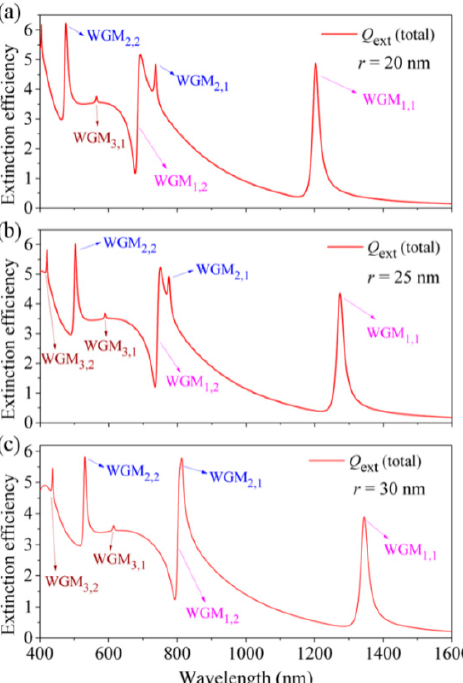
Figure 7. ( a – c ) The calculated total extinction efficiency spectra of the spherical HMM cavity for different r from 20 nm ( a ) and 25 nm ( b ) to 30 nm ( c ), respectively. Other structural/material parameters: s = 20 nm, d = 15 nm and n = 1.4.